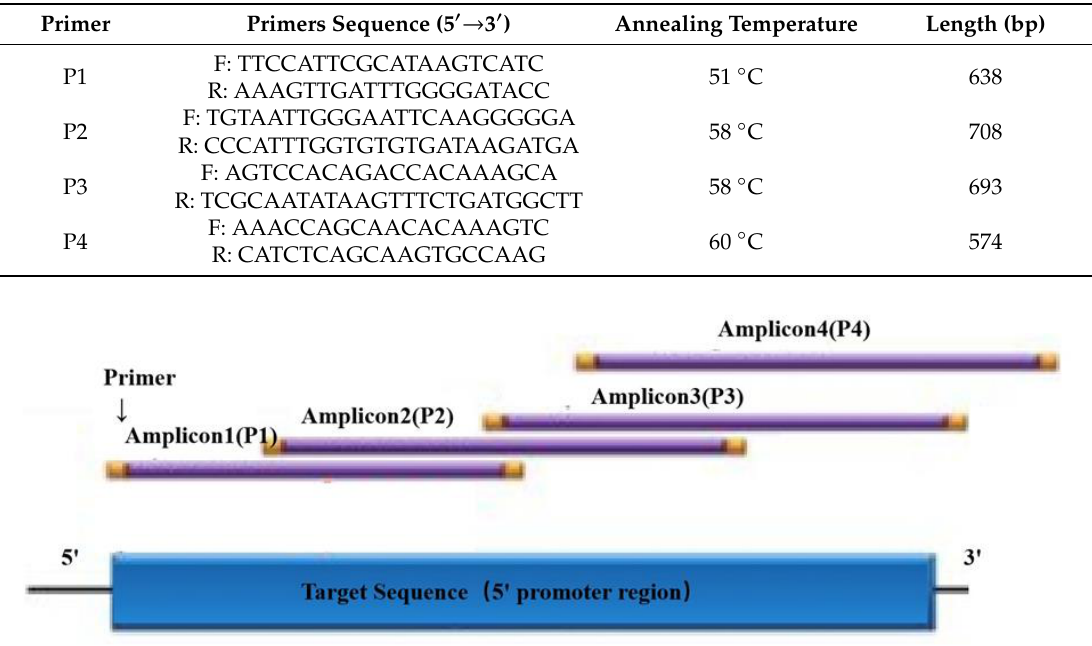
Figure 1. Amplicon layout in the promoter region of the interleukin 8 ( IL-8 ) gene.